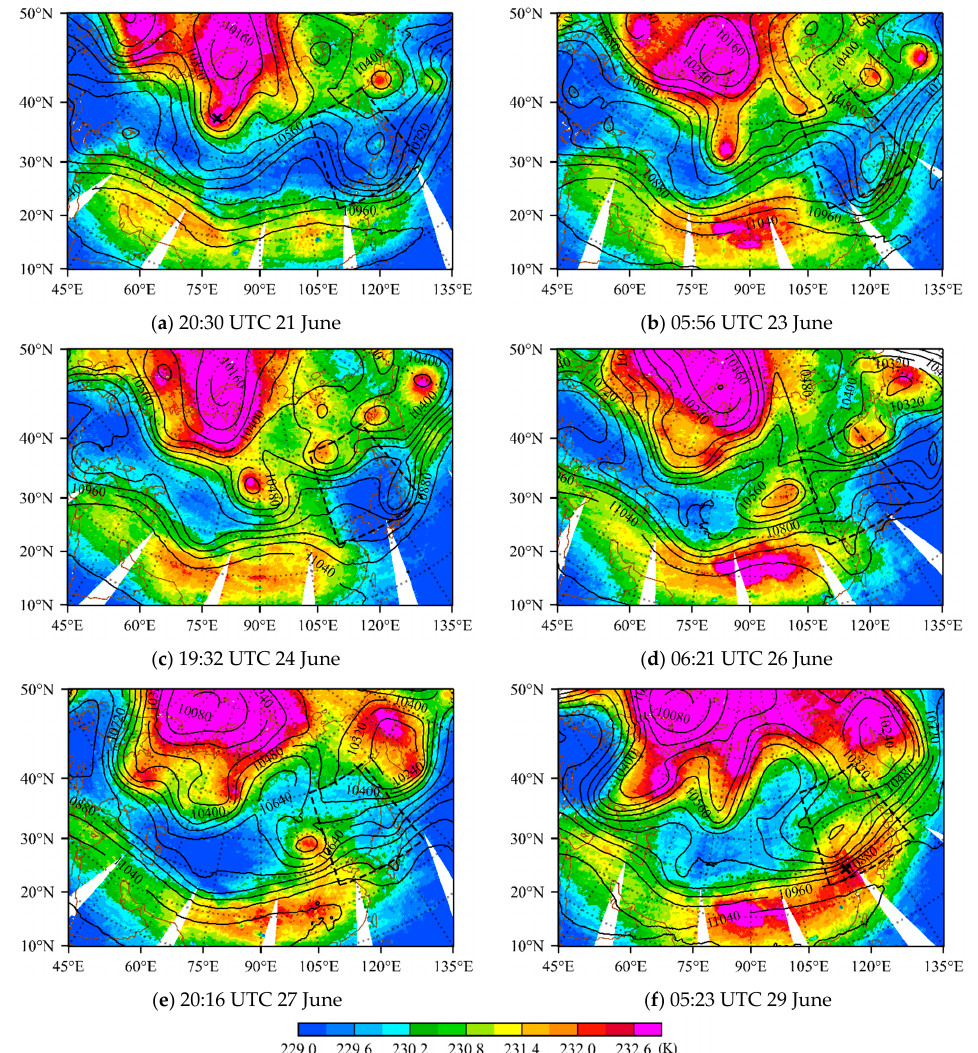
Figure 6. Spatial distributions of MWTS-2 limb-corrected brightness temperature observations (color shaded, unit: K) of channel 6 from 21 to 29 June 2019 with ERA5 250 hPa geopotential height (contours, interval: 80 gpm) at 06:00 UTC for satellite ascending node and 18:00 UTC for descending node of each day. The time when the satellite scanned the location (50°N, 90°E) is labeled below each figure.